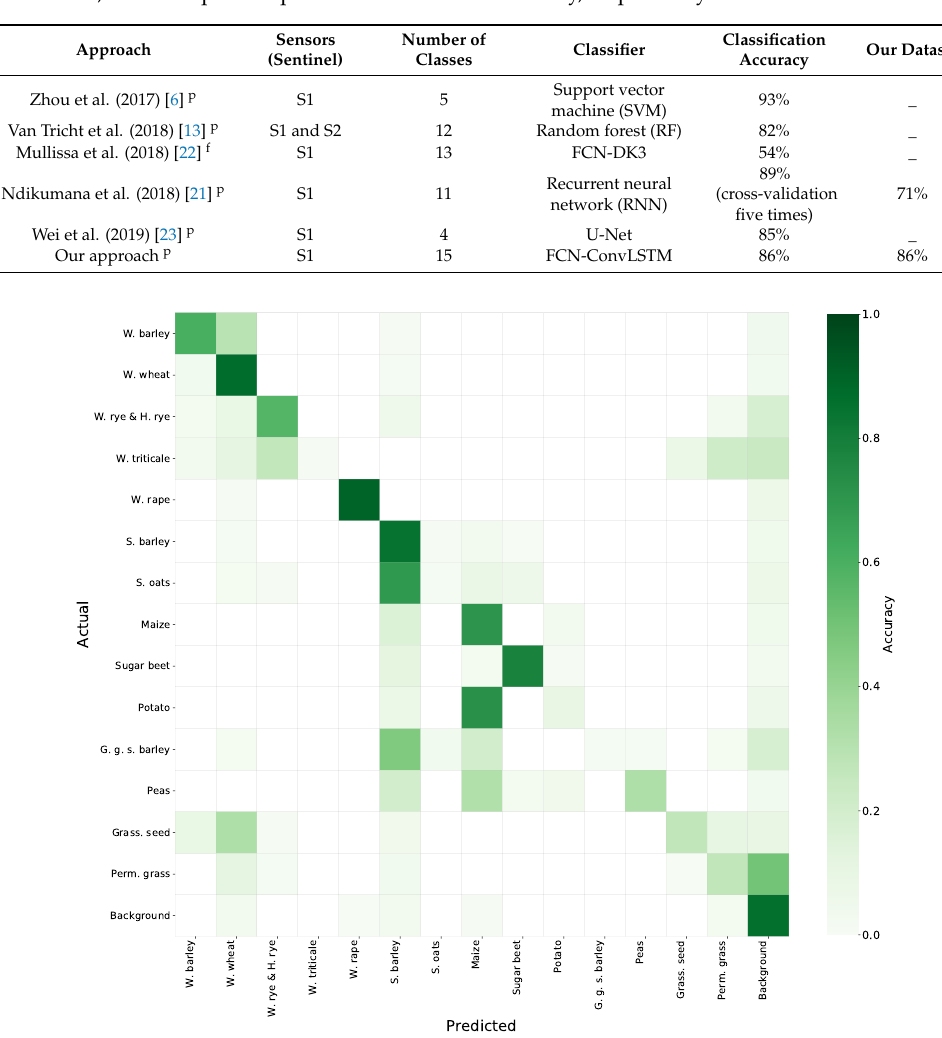
Table 3. Comparison of classification accuracies between our approach and other state-of-art methods. In the table, p and f represent pixel and field-based accuracy, respectively.